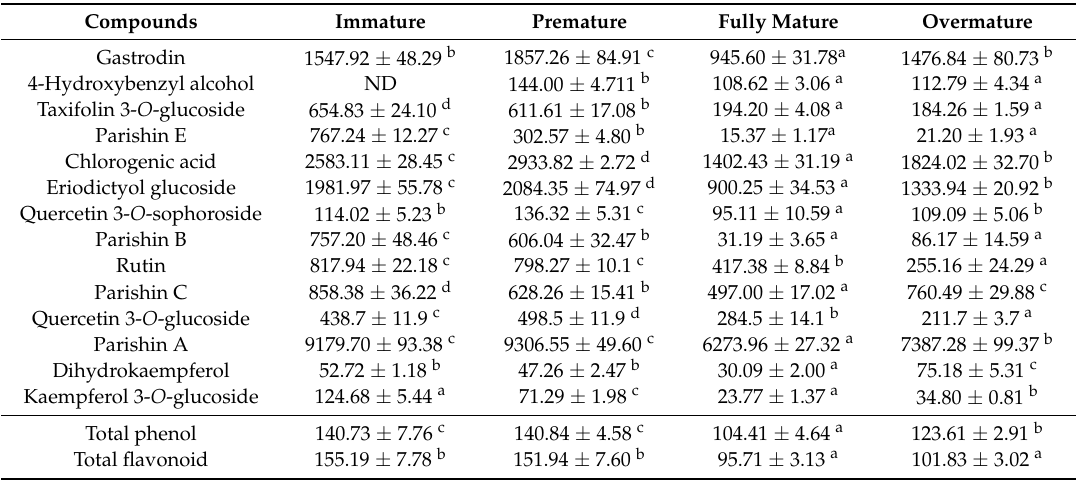
Table 7. Concentration of polyphenolic compounds, total phenol, and total flavonoid at different maturity stages of M. tricuspidata